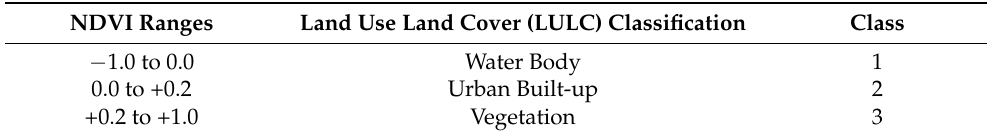
Table 2. NDVI ranges for LULC Classification.